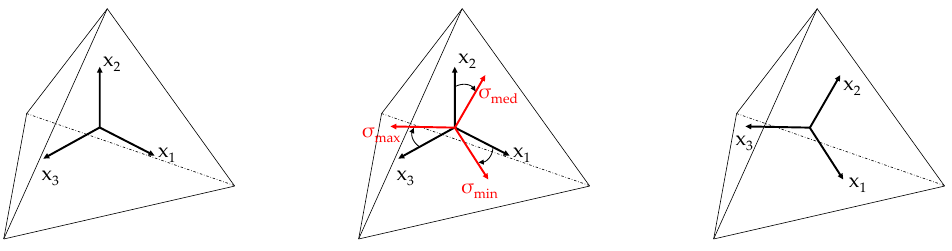
Figure 1. Orientation of element updated based on the principal stress directions of guiding